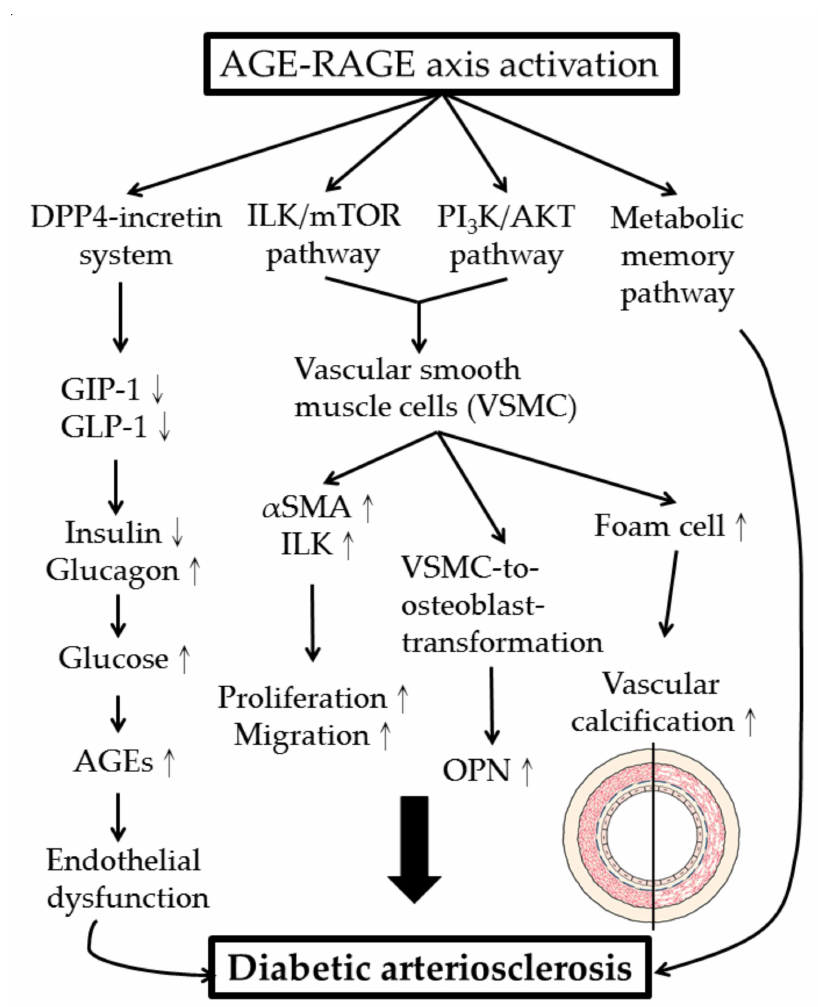
Figure 4. Metabolic and molecular mechanisms of AGE–RAGE axis activation in development of diabetic arteriosclerosis. DPP4: dipeptidyl peptidase 4; GIP-1: glucose-dependent insulinotropic polypeptide-1; GLP-1: glucagon-likepeptide-1; VSMC:vascularsmoothmusclecell; ILK:integrin-linked kinase; α -SMA: α -smooth muscle actin; OPN: